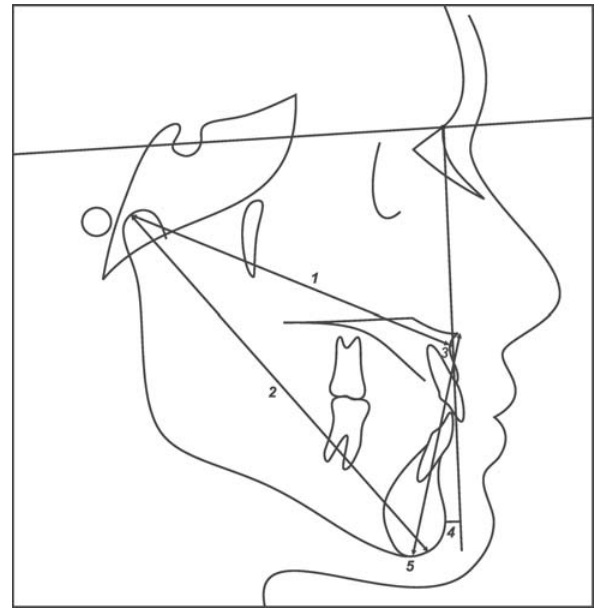
FIGURE 2- Cephalometric measurements used (in mm): 1-Co-A; 2-Co-Gn; 3-A-NPerp; 4-P-NPerp; 5-